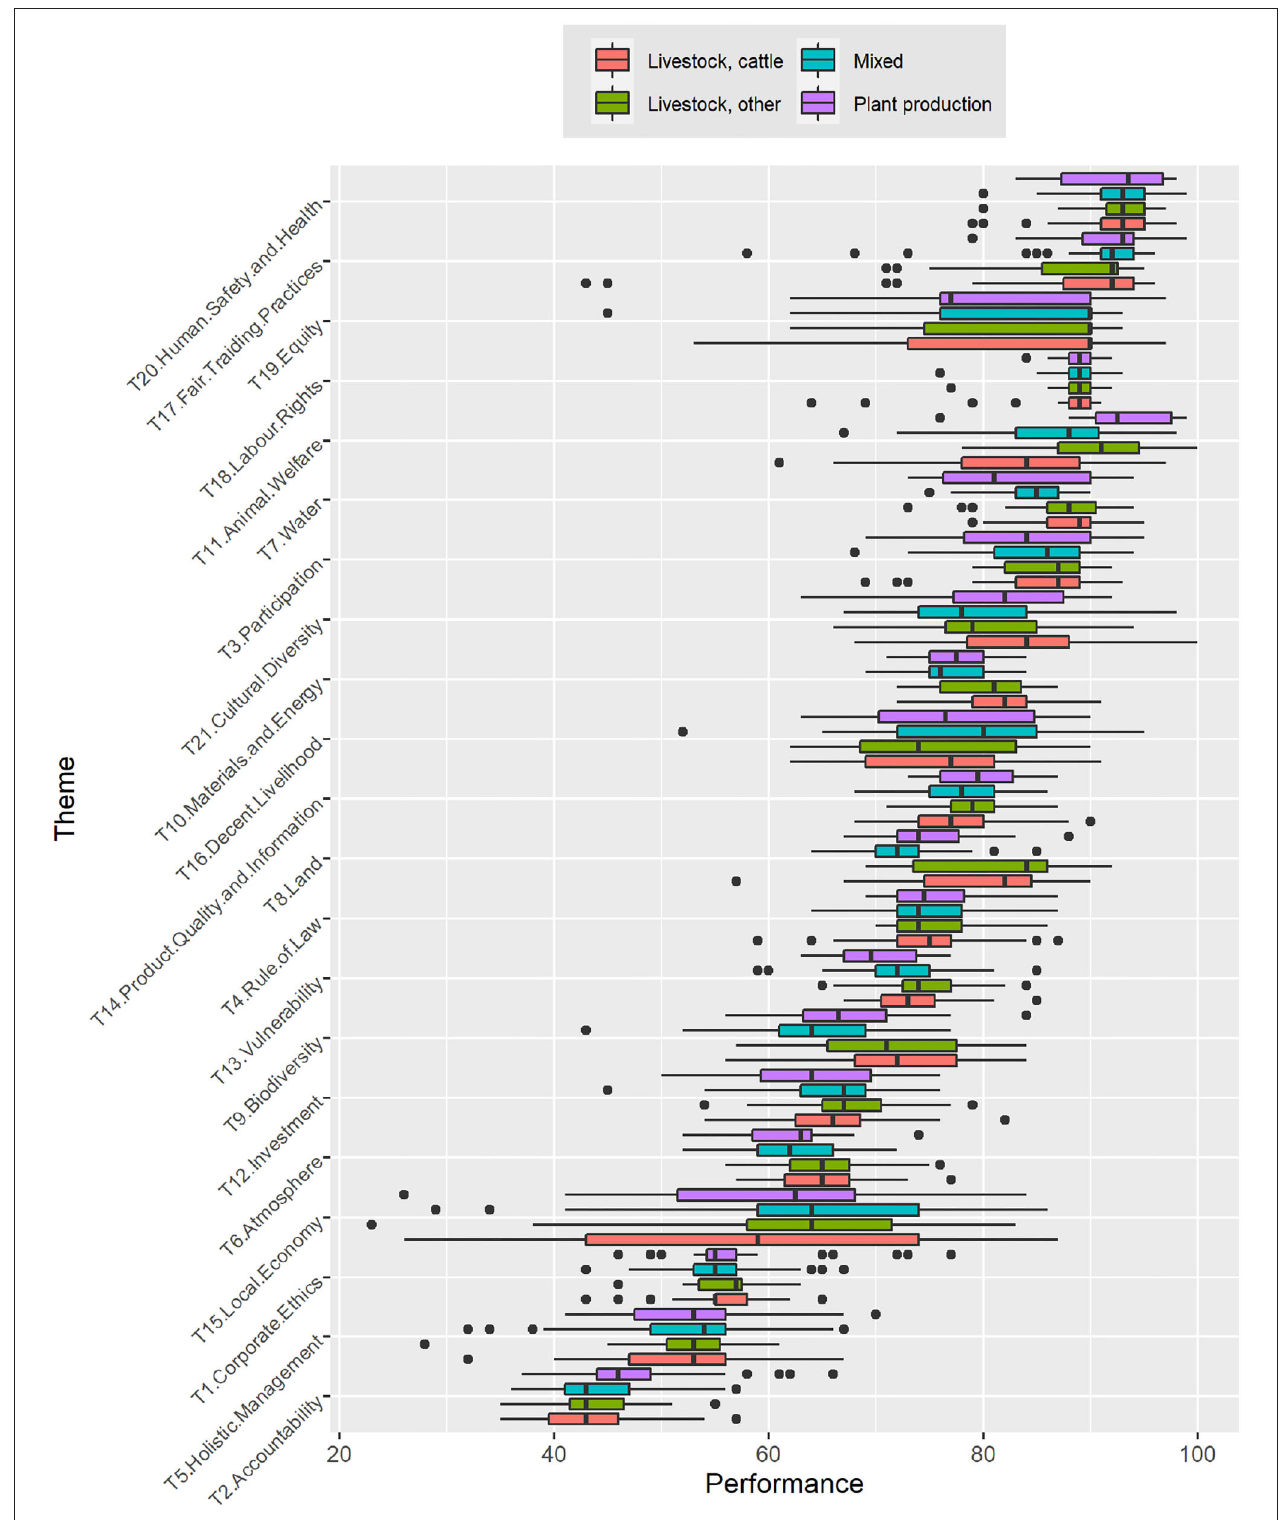
FIGURE 3 | Theme performance (in % goal fulfillment) according to simplified farm type.